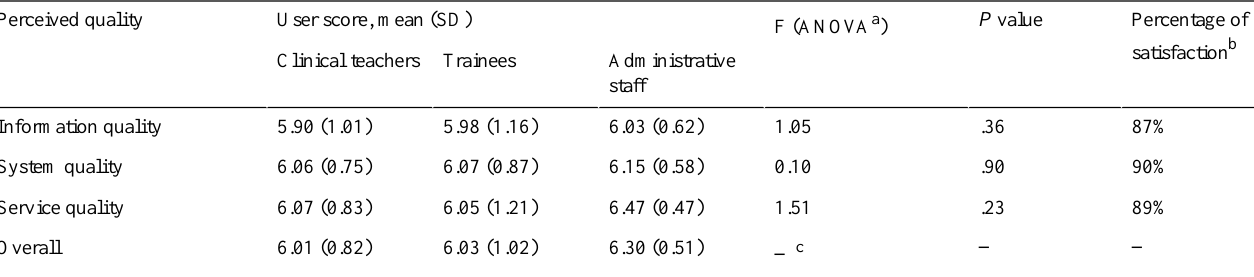
Table 2. Perceived quality of the competency-based learning and assessment system